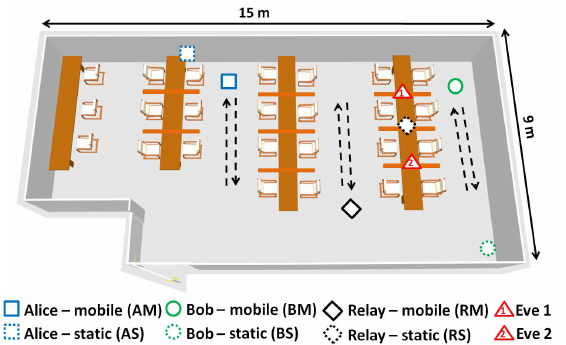
Figure 5: Floor plan of experimental set-up in an indoor environment. Table 1: Various experimental scenarios with nodes as mobile and stationary Expt Stationary Mobile Alice Relay